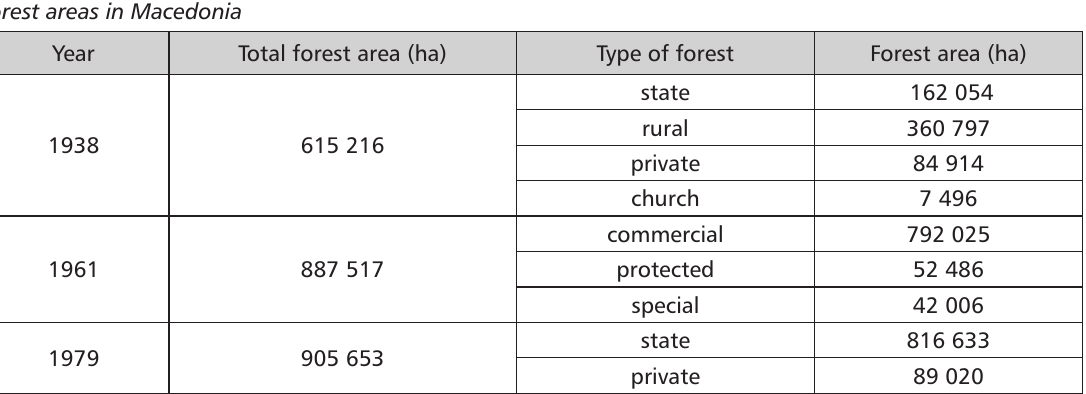
Forest areas in